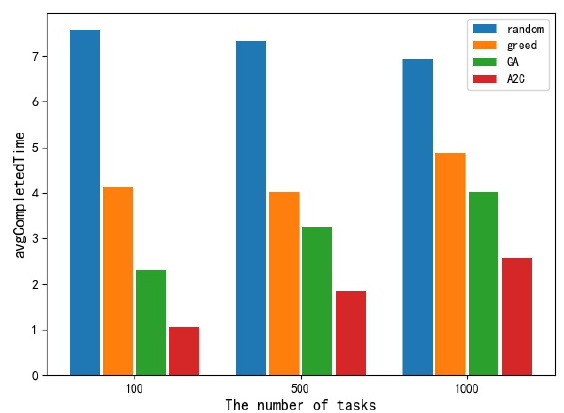
Figure 7. Comparison of different algorithms in avgCompletedTime .